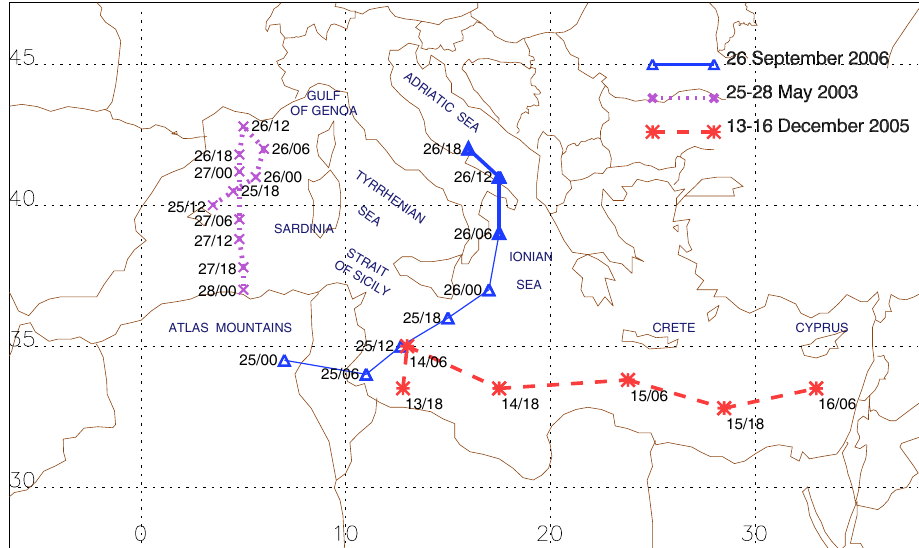
Fig. 2. Track of the three medicanes: (a) 26 September 2006 case (blue) as derived from ECMWF operational analyses every 6h from 25 September 2006 at 00:00UTC to 26 September 2006 at 18:00UTC. The thick part of the line corresponds to the track of the medicane. (b) 25–28 May 2003 case (dotted purple) as derived from satellite imagery every 6h from 25 May 12:00UTC to 28 May 00:00UTC (after Fita et al., 2007a). (c) 13–16 December 2005 case (dashed red) as derived from satellite imagery every 12h from 13 December 18:00UTC to 16 December 06:00UTC (after Fita et al., 2007a; Luque et al., 2004).